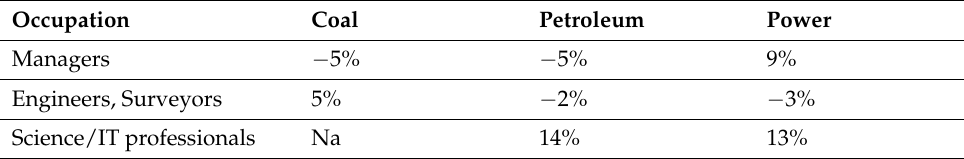
Table 3. Average annual growth rate in share of women in occupations, 2010–2020. Occupation Coal